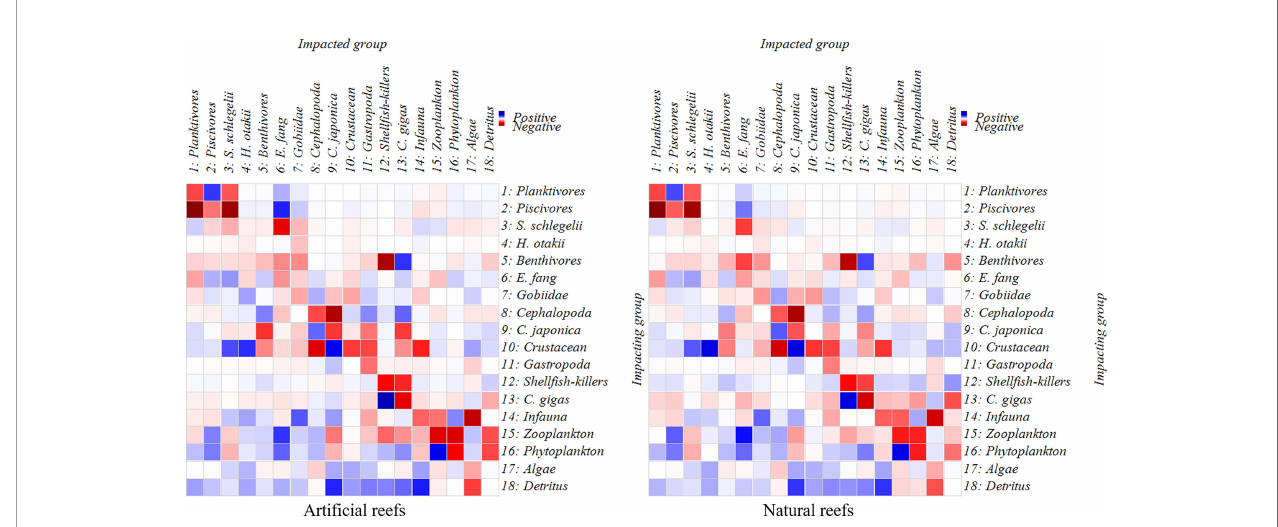
FIGURE 5 | Mix trophic impacts analysis for the arti fi cial and natural reef ecosystems on the coast of Yellow Sea, China. Positive impacts are denoted in blue rectangles while negative impacts in red rectangles, and the color concentration represents the impact